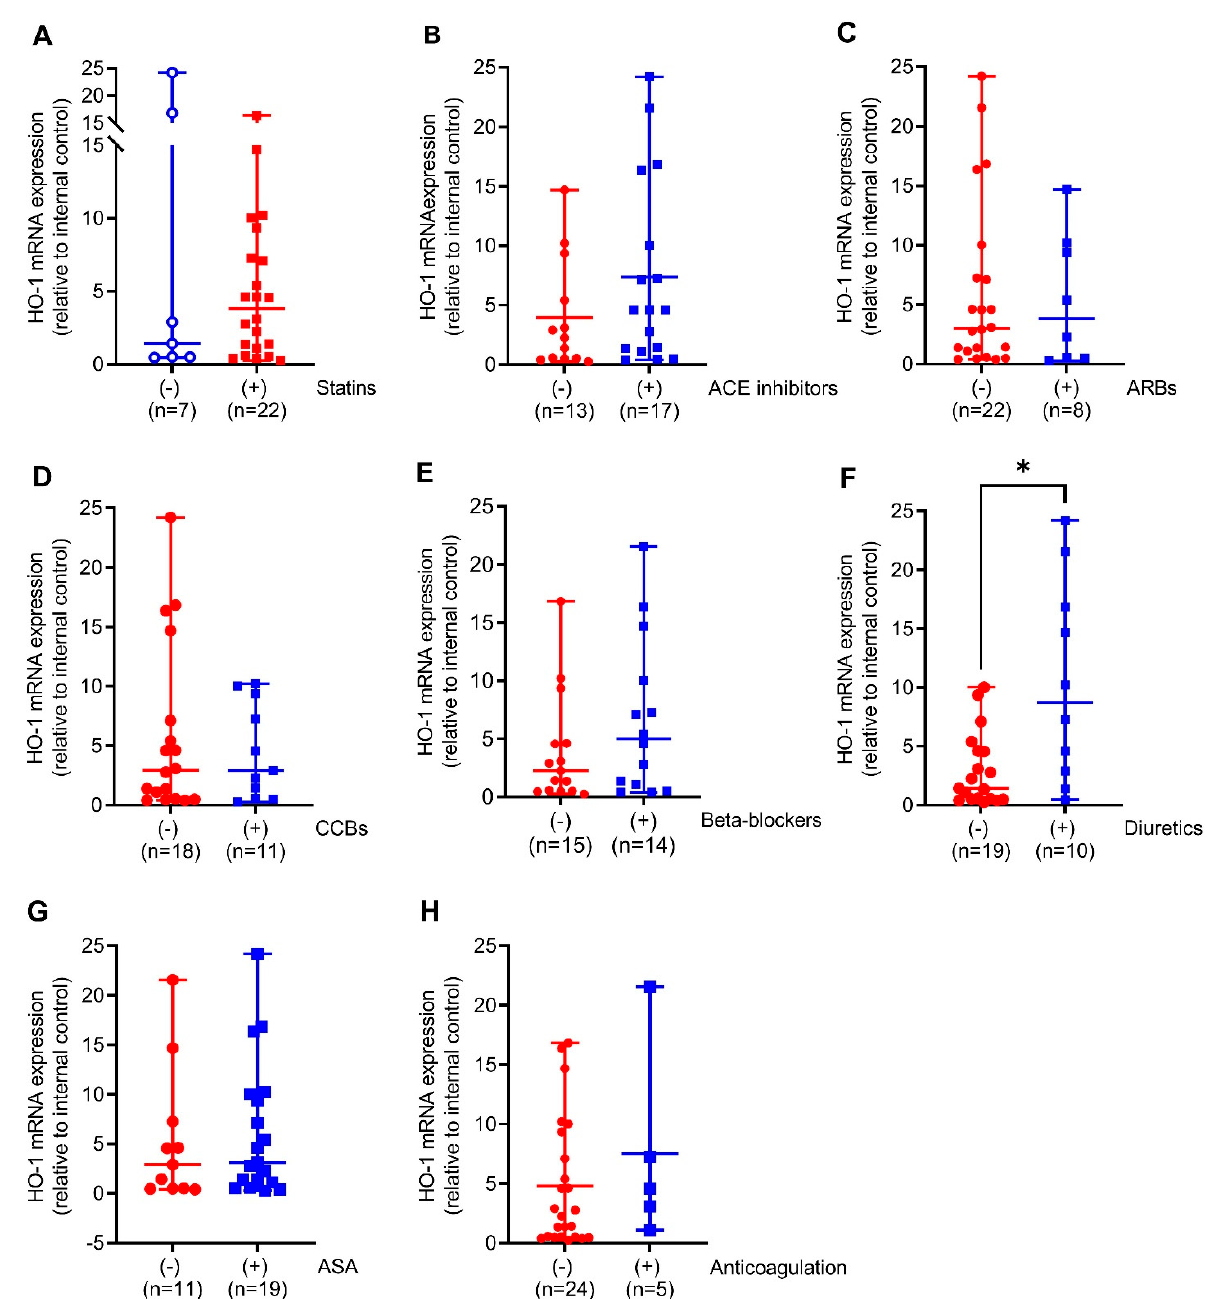
Figure 2. Comparison of HO-1 mRNA expression in response to different pharmacological therapies in aortic tissues obtained from patients undergoing elective open surgical repair due to AAA. ( A – H ) mRNA expression was measured by real-time PCR, and data were normalized to an internal control that was set to 1. Patients were divided according to the presence (+, blue) or absence ( − , red) of the indicated therapy. Statistics: Statistically significant outliers were detected by Grubb’s outlier test. Data are presented as scatter dot plots, where the horizontal line depicts the mean or median with range depending on normality testing. ( B , C ) Unpaired t -test. ( A , D – H ) Mann–Whitney U test. * p < 0.05 (+) vs. ( − ) treatment. ( A , D – F , H ) One significant outlier was detected in each group. ( B , G ) One significant outlier was detected in the ( − ) group. ( C ) One significant outlier was detected in the (+) group. Abbreviations: ACE, angiotensin-converting enzyme; ARB, angiotensin II receptor blockers; ASA, acetylsalicylic acid; CCB, calcium channel